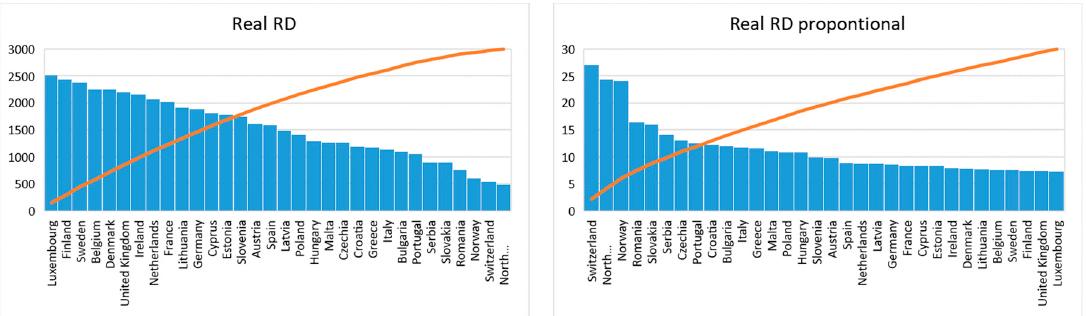
Figure 29. Compared real values, RD factors. J. Risk Financial Manag. 2020 , 13 , x FOR PEER REVIEW